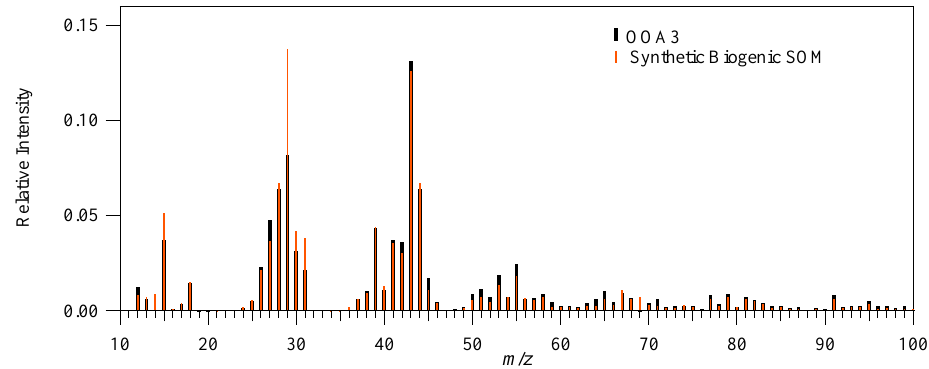
Figure 7. Comparison of the OOA-3 factor to a synthetic mass spectrum obtained from a linear combination of the mass spectra of laboratory- generated biogenic SOM (30% α -pinene-derived SOM, 20% β -caryophyllene-derived SOM, and 50% isoprene-derived SOM at mass concentrations of 0.4 to 0.7µgm − 3 ).